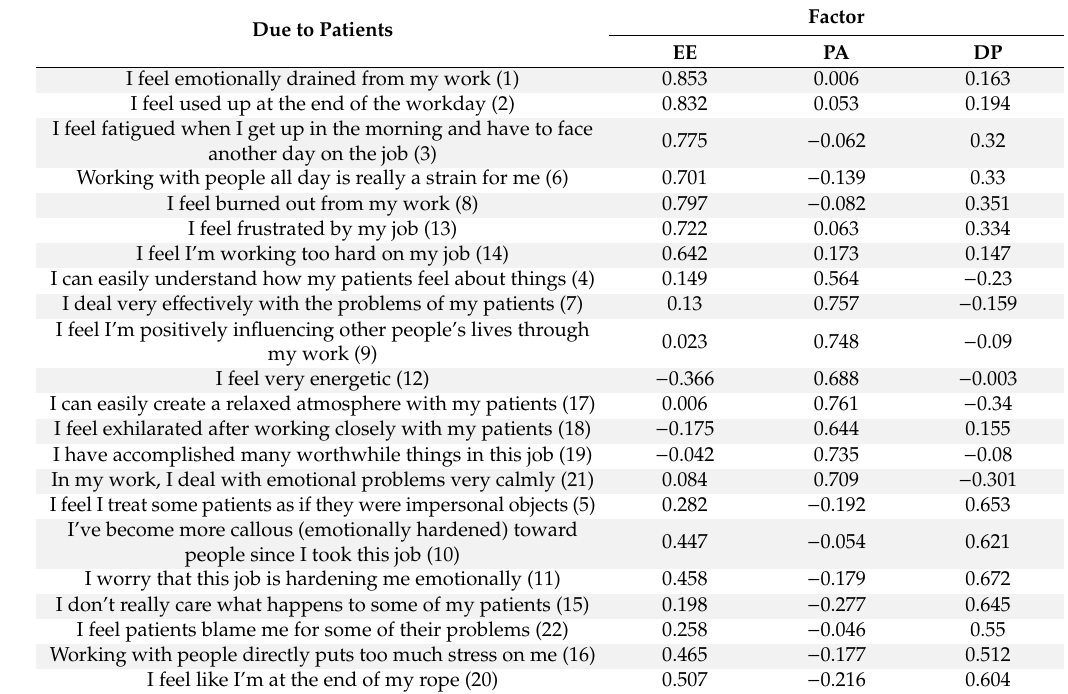
Table A2. Rotated Factor Matrix for Burnout due to